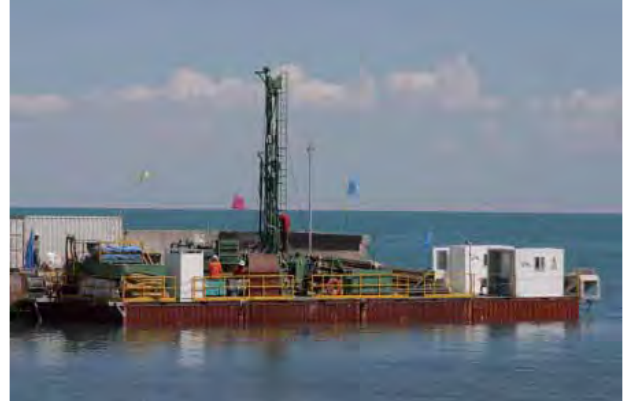
Figure 2. The GLAD800 drilling system towed away from the dock site for fi rst coring.